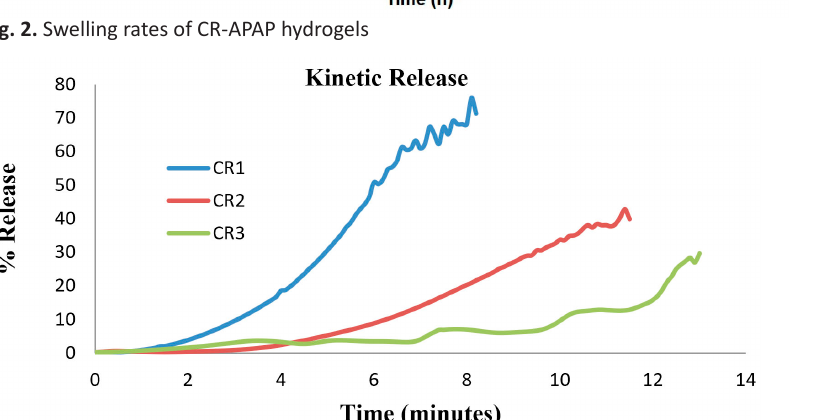
Fig. 3. Kinetic release profile of CR-APAP